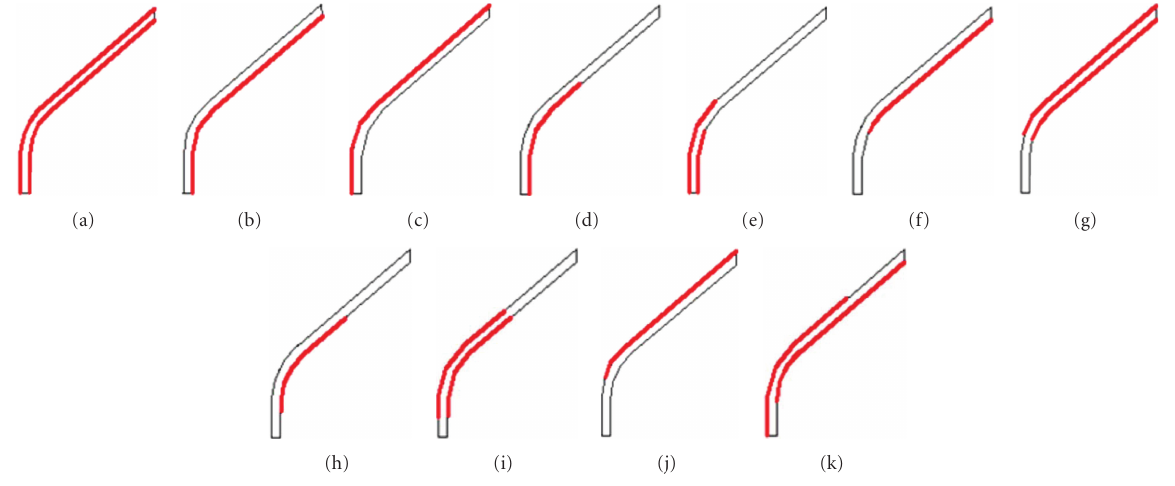
Figure 2: Various GFRP reinforcement configurations considered. Table 1: Material properties used in the